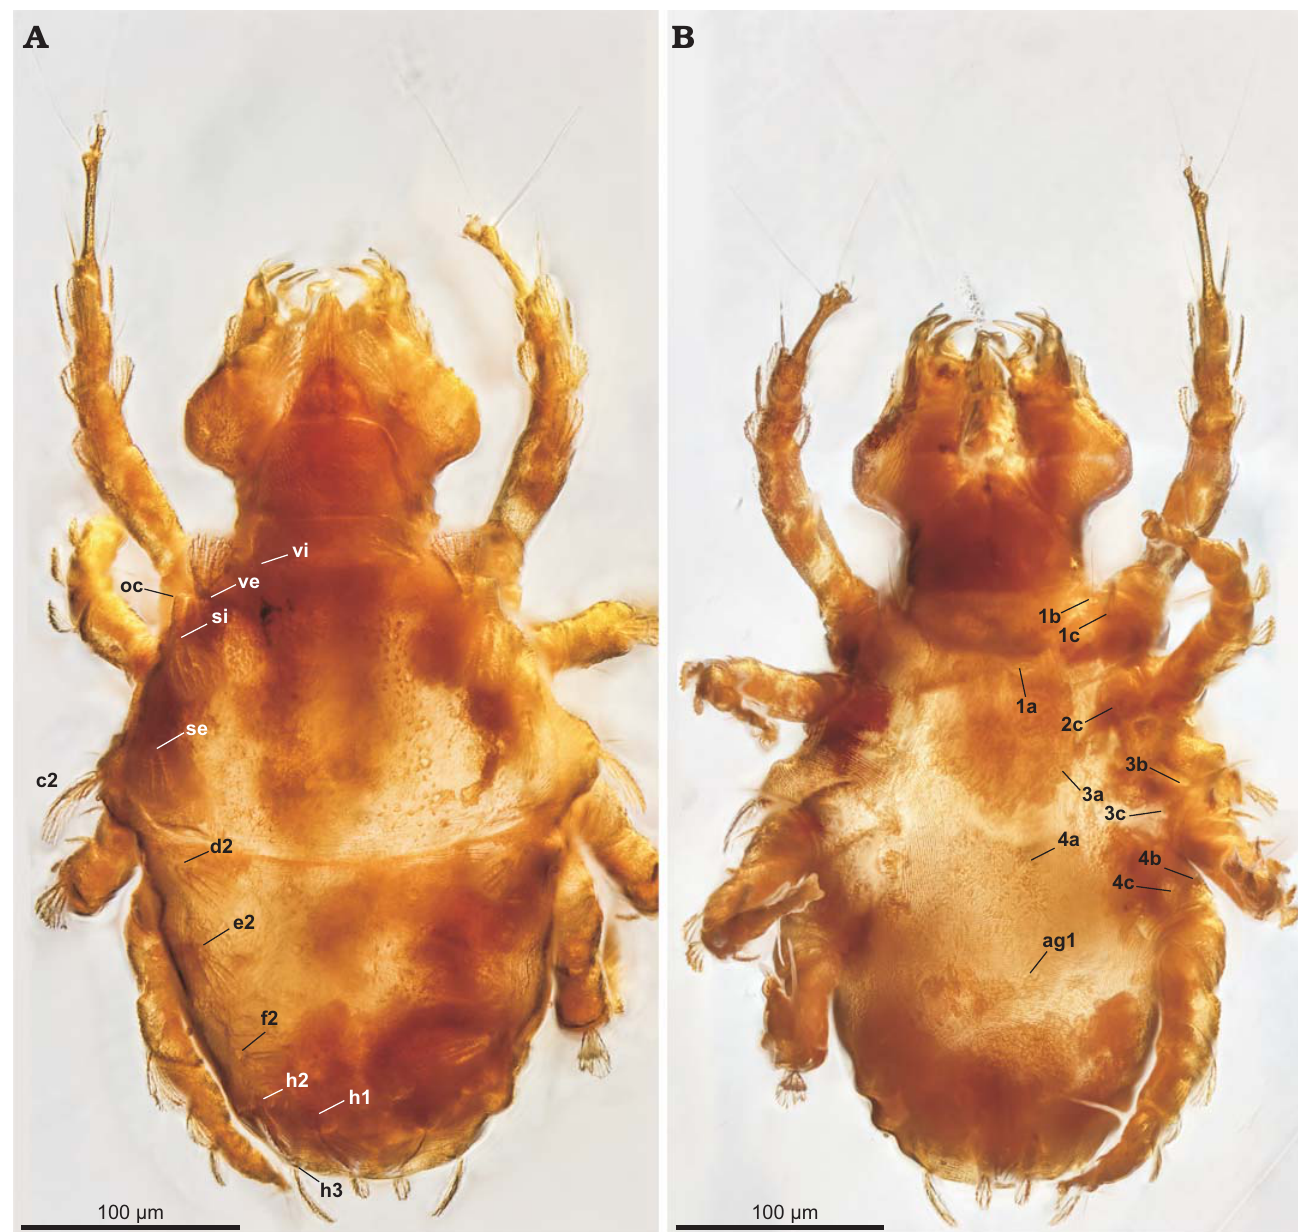
Fig. 2. Cheyletid mite Cheletomimus crinitus sp. nov., female holotype (SMF Be 2537, ex. CCHH 448-1) from Baltic amber (Baltic Sea coast, most likely Sambian Peninsula, middle to upper Eocene, 37–54.5 Mya), brightfield layered micropanaramas, each combined from ca. 170 focal planes. Dorsal ( A ) and ventral ( B ) views. Abbreviations: 1a–c, 2c, 3a–c, 4a–c, coxal setae of coxae 1–4, respectively; ag1, anterior aggenital seta; c2, d2, e2, f2, h1–h3, dor- sal setae, associated with body segments C, D, E, F, H, respectively; oc, ocellus; se, scapular external prodorsal seta; si, scapular internal prodorsal seta; ve, vertical external prodorsal seta; vi, vertical internal prodorsal